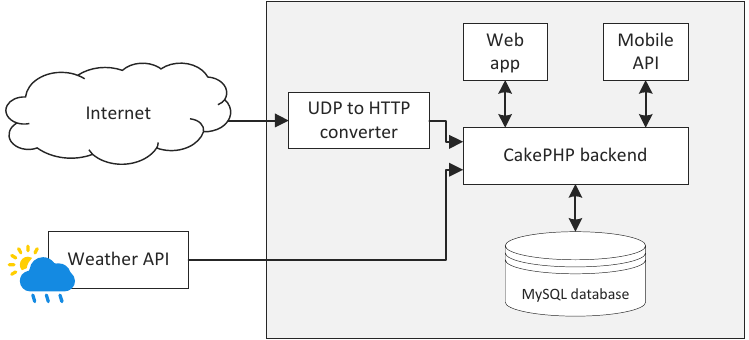
Figure 7. The Winet server.